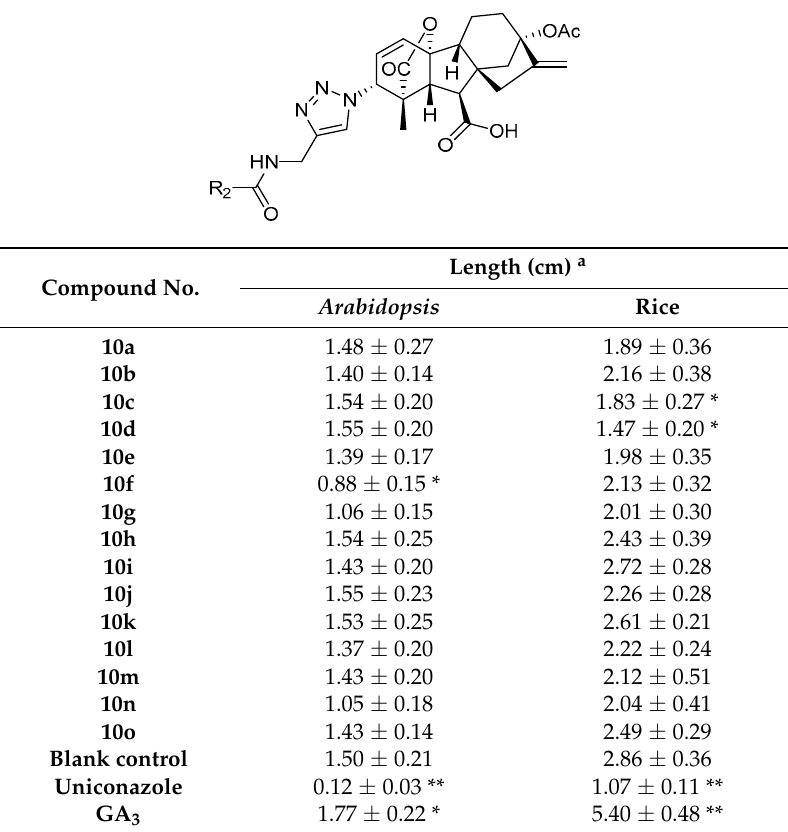
Table 1. In vivo activities of the synthetic GA 3 derivatives (100 µ M).